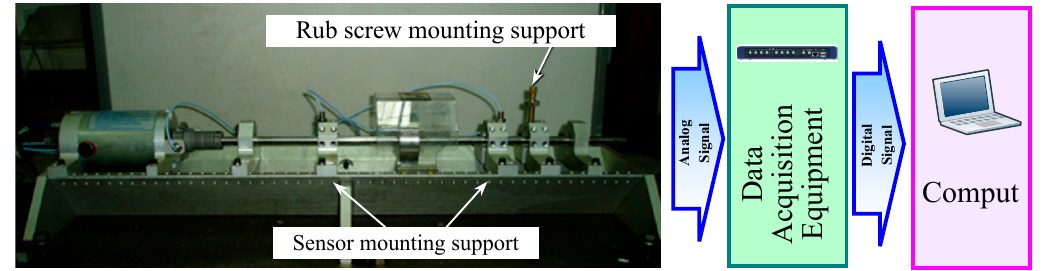
Figure 14. Test rig that simulates rub impact faults.